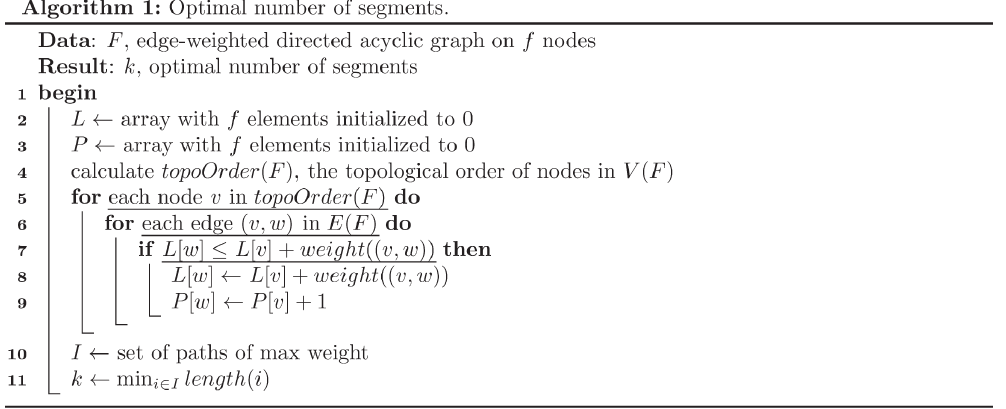
Figure 3. Algorithm 1 - Optimal number of segments. It presents the algorithm for computing the optimal segmentation based on the longest path in a directed acyclic graph.